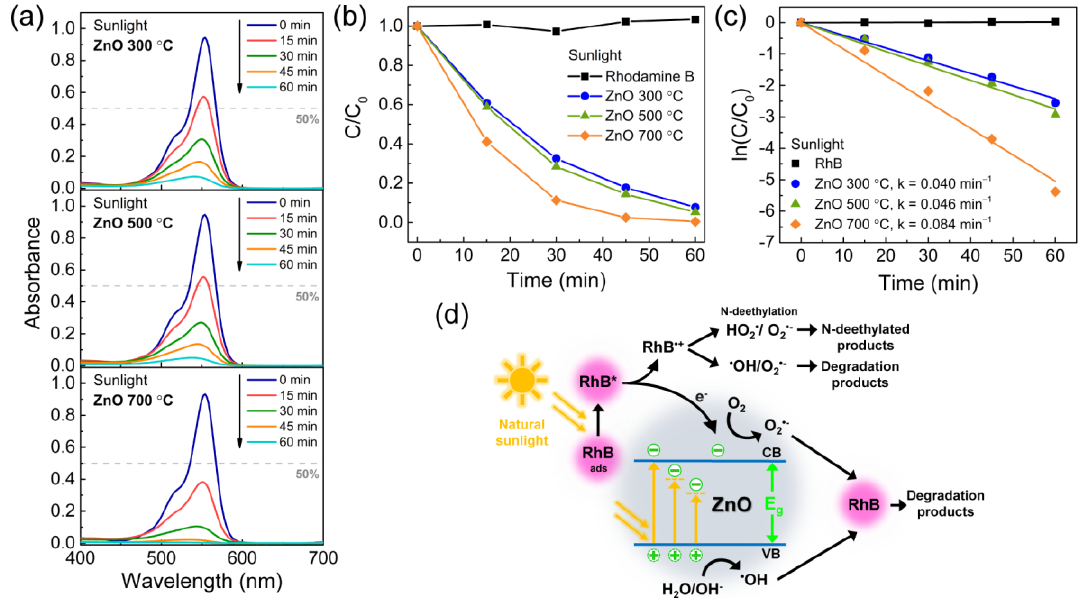
Figure 5. ( a ) Absorbance spectra of RhB recorded at different degradation times under solar light for ZnO samples calcinated at 300, 500, and 700 °C. ( b ) Degradation ratio C/C 0 of RhB vs. sunlight exposure time for all the produced porous ZnO samples. ( c ) ln( C/C 0 ) vs. sunlight exposure time and the resultant degradation rates k for each tested sample. ( d ) Solar light photocatalytic mechanism of ZnO.